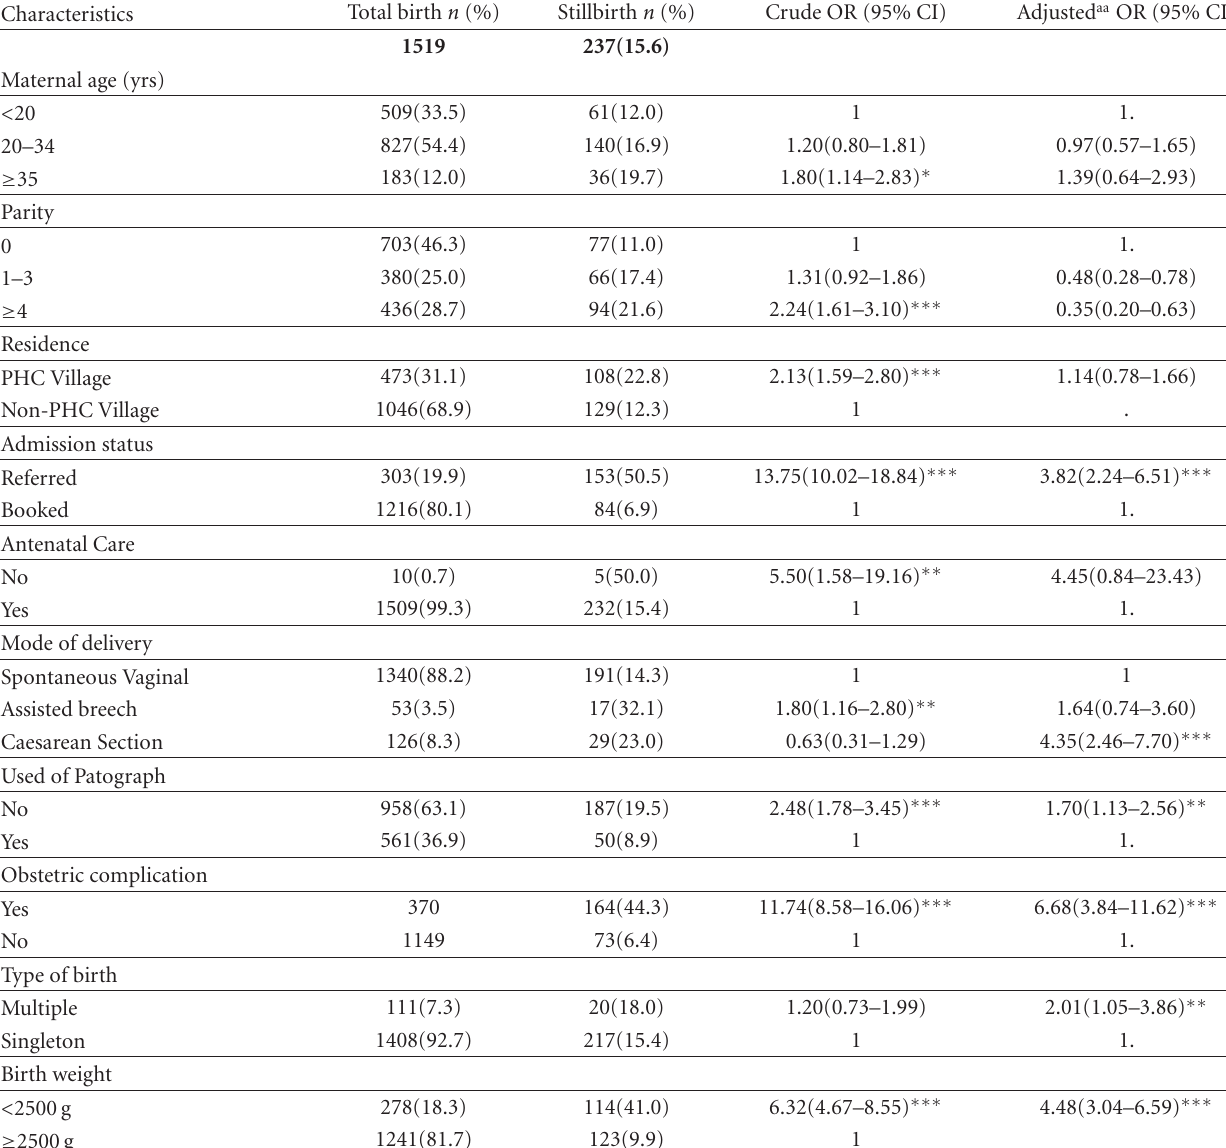
Table 1: Demographic/reproductive and obstetric factors associated with